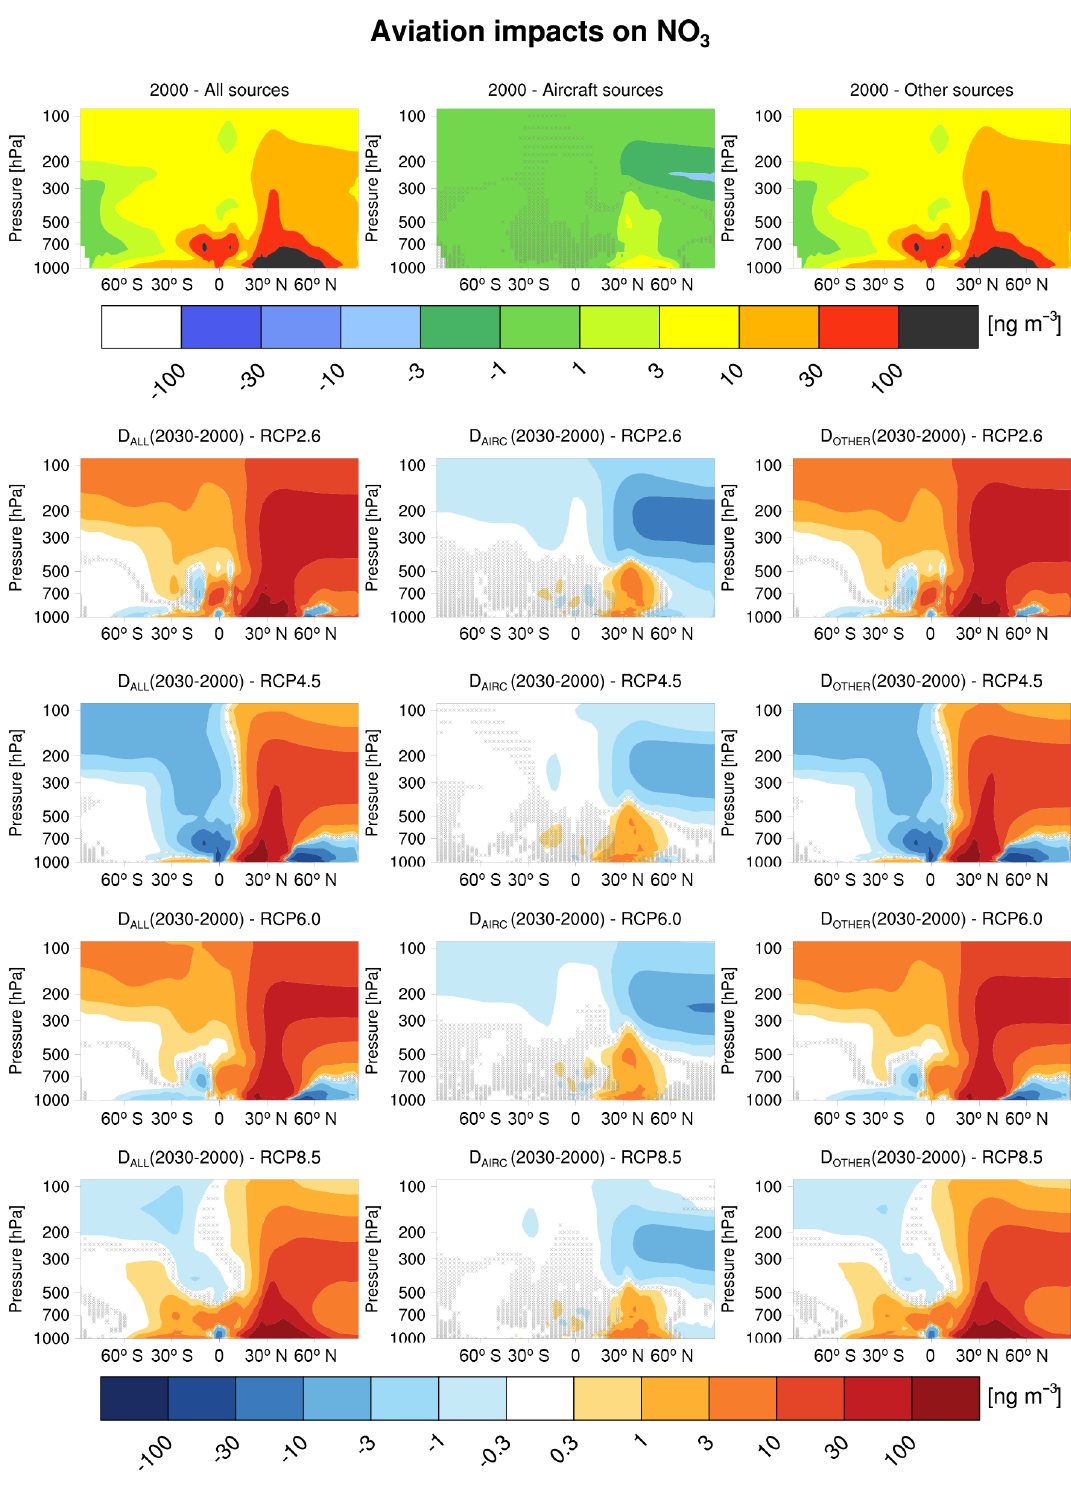
Figure 5. As in Fig. 3 but for aerosol nitrate